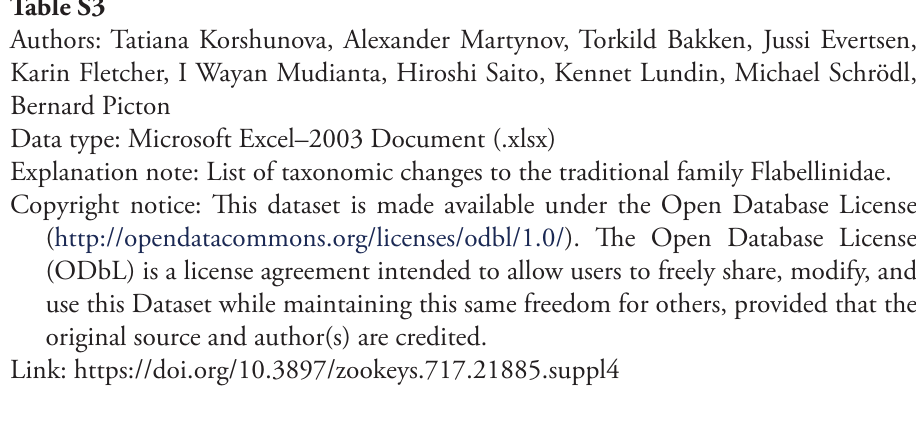
Authors: Tatiana Korshunova, Alexander Martynov, Torkild Bakken, Jussi